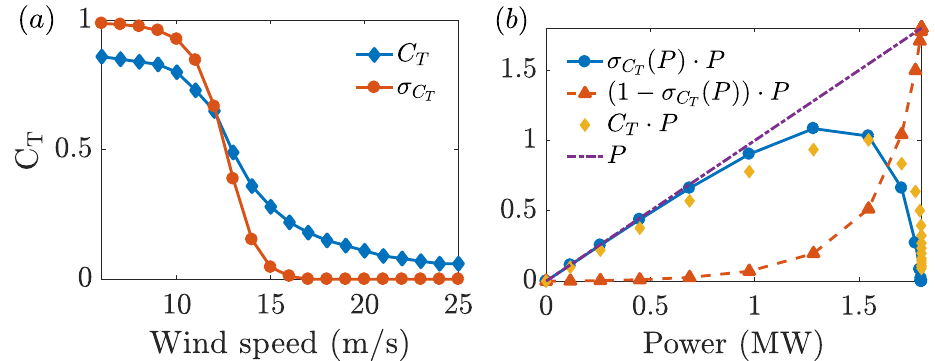
Figure 2. ( a ) Vestas V80 manufacturer rated coefficient of thrust curve ( C T ) compared with the Sigmoid-type activation function σ C by the wind turbine C T curve. The activation function is given by Equation (8). ( b ) Nonlinearities applied to the Vestas V80 power curve. The sigmoid-type activation function is σ C nonlinearity was designed such that σ C